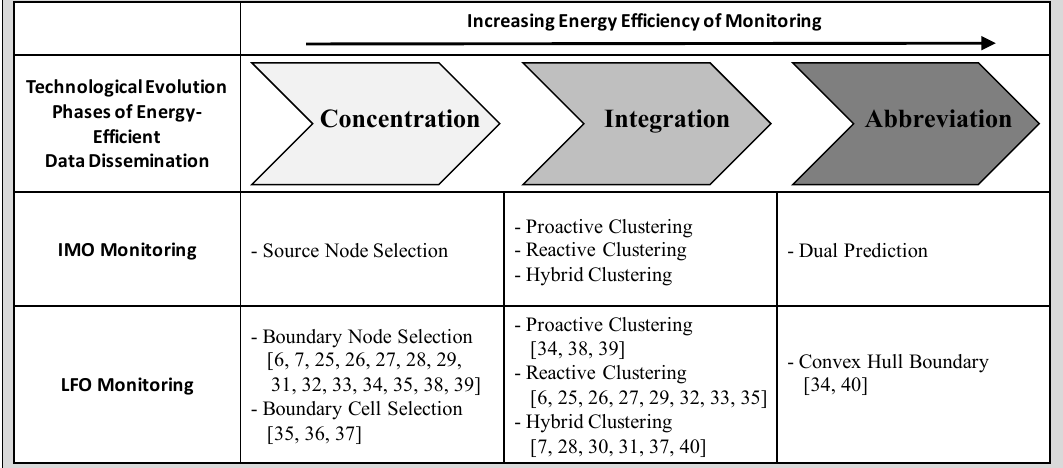
Figure 2. Survey on energy-efficiency of monitoring for IMOs and LFOs by the technological evolution